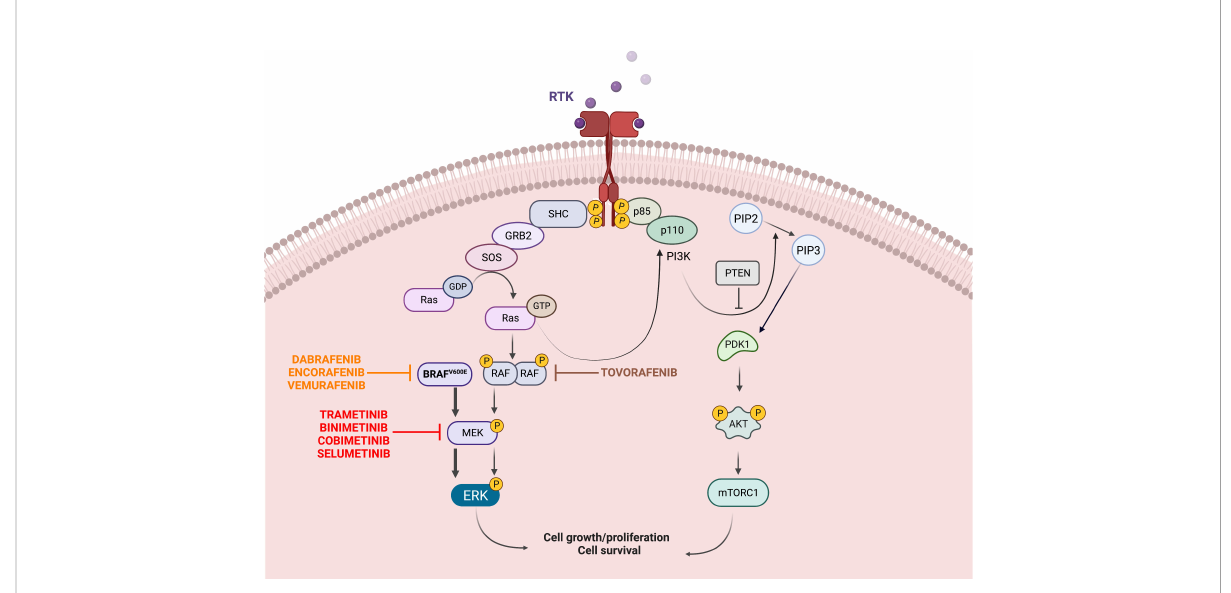
FIGURE 1 Oncogenic BRAF/MAPK signaling. The mitogen-activated protein kinase (MAPK) pathway is essential to the regulation of cellular growth, proliferation, and survival. Upstream of BRAF, growth factors binding to receptor tyrosine kinases (RTKs) at the cell surface lead to phosphorylation of RAS proteins, which then activate BRAF. Signal transduction continues downstream from BRAF to MAPK kinase (MEK) 1 and MEK2, and fi nally to ERK, which phosphorylates multiple targets, leading to increased cell survival, proliferation and differentiation. The V600E mutation results in constitutive activation of BRAF and downstream activation of MEK and ERK, in a RAS-independent manner. Speci fi c inhibitors have been synthetized to target the mutated BRAF (Dabrafenib, Encorafenib, Vemurafenib) and the downstream MEK (Trametinib, Binimetinib, Cobimetinib, Selumetinib); more recently pan-raf inhibitors such as Tovorafenib have been developed. The PI3K/AKT/mTOR pathway is another survival pathway and its overactivation has been associated with BRAFi resistance (Created with